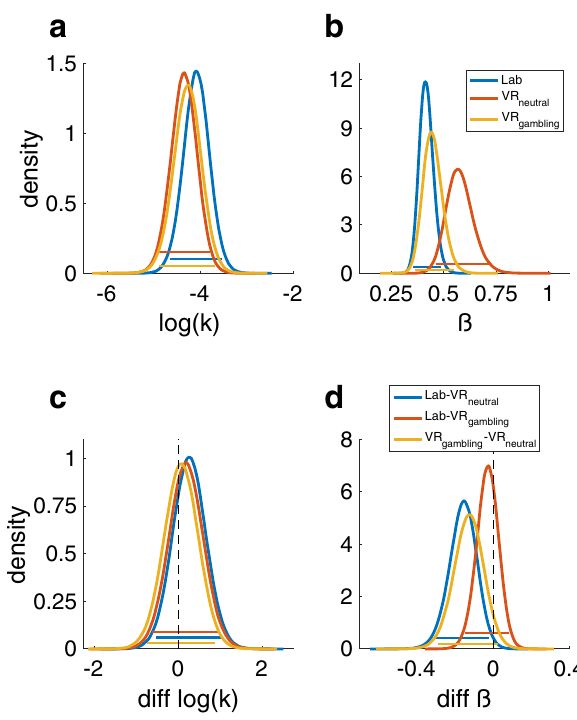
Figure 3. Posterior distributions of the parameters of the hyperbolic discounting model. Colored bars represent the corresponding 95% HDIs. ( a ) Posterior distribution of the log(k) parameter (reflecting the degree of temporal discounting) for all three sessions. ( b ) Posterior distribution of the β or inverse temperature parameter (reflecting decision noise). ( c ) Pairwise difference distributions between the posteriors of the log(k) parameters of all three sessions. ( d ) Pairwise difference distributions between the posteriors of the β parameters of all three sessions.